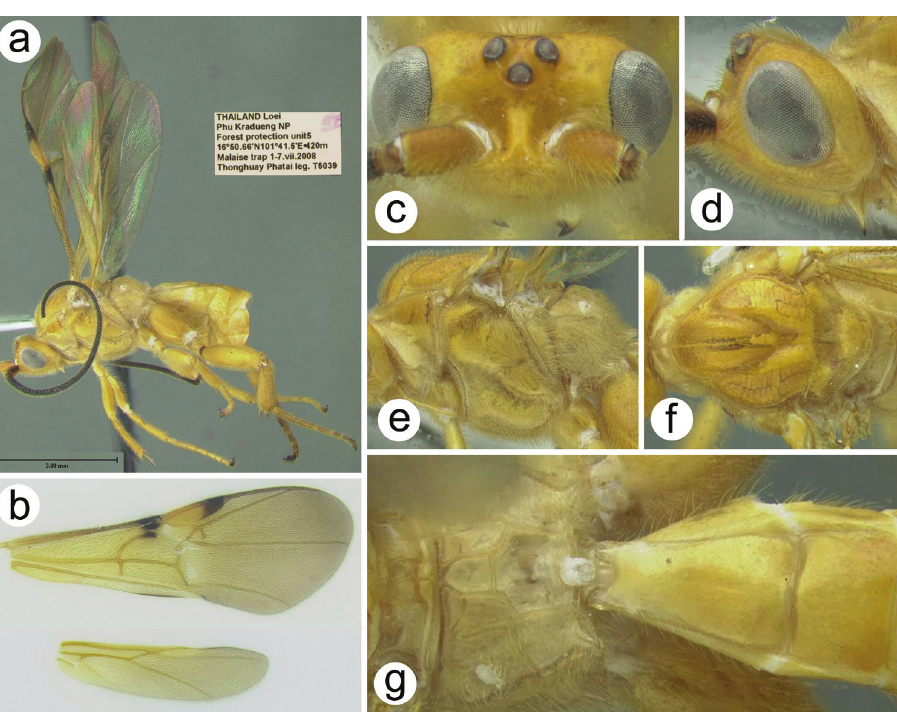
Figure 3. Zelodia brevifemoralis Achterberg and Long a lateral habitus b wings c dorsal head d lateral head e lateral mesosoma f dorsal mesosoma g dorsal propodeum and